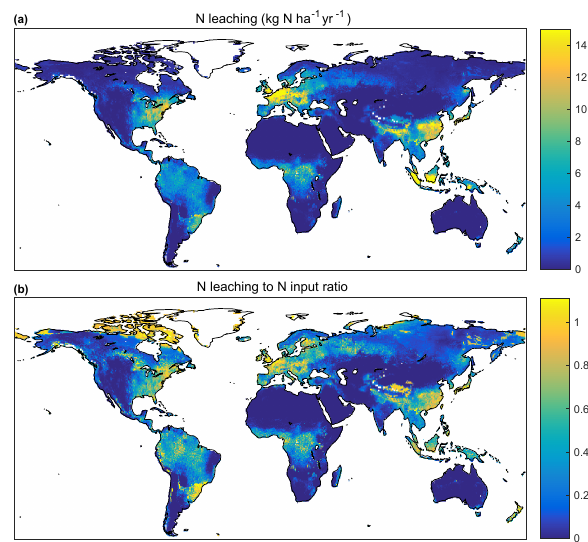
Figure 4. Mineral N leaching for the true historical simulation ( + Ndep + clim + CO 2 ) averaged over the period 1997–2006. (a) N leaching; (b) ratio of N leaching and N input (N deposition + BNF). For readability, the colour axes have been cut off at the 99% quan-